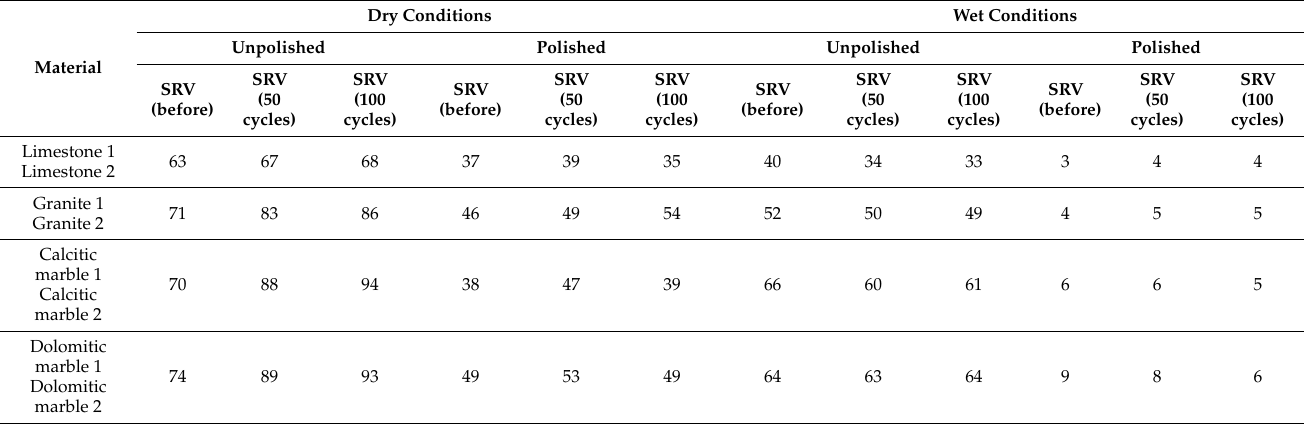
Table 1. Average SRV before and after freeze–thaw cycling.